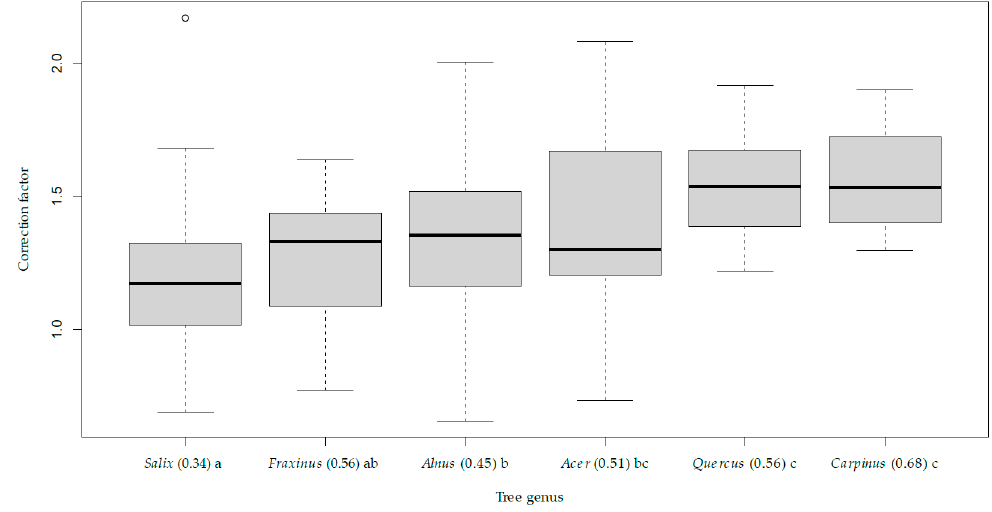
(cid:16) (cid:17) 1.5534 (cid:17) − 0.7951 (cid:16) ) (cid:2879)(cid:2868).(cid:2875)(cid:2877)(cid:2873)(cid:2869) × (1 + (cid:3027)(cid:3044)(cid:2871)(cid:2868) ) (cid:2869).(cid:2873)(cid:2873)(cid:2871)(cid:2872) ] × (cid:2869)(cid:2868)(cid:2868) (cid:3009)(cid:2877)(cid:2868) 1 + Pground ] depending on tree species. 1 + Zq 30 H 90 100